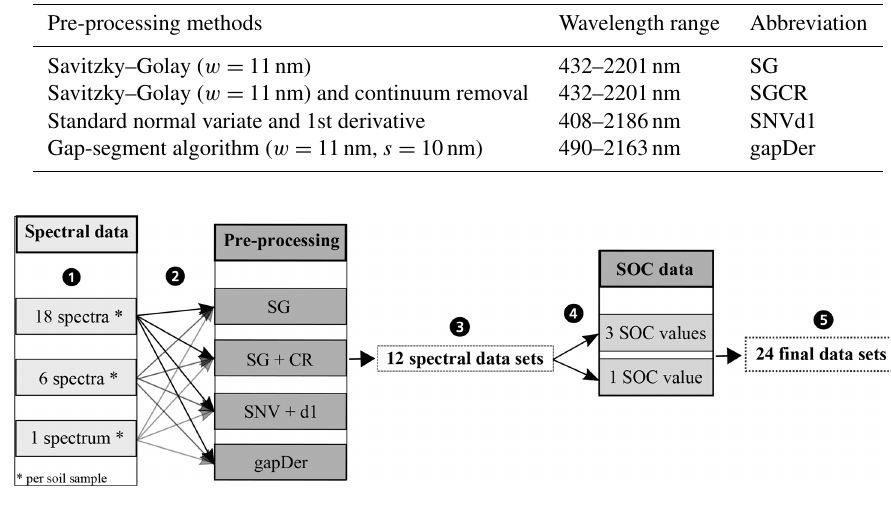
Figure 4. Datasets to investigate the uncertainty propagation. SG − Savitzky–Golay, CR − continuum removal, SNV − standard normal variate, d1 − 1st derivative, gapDer − gap-segment algorithm.